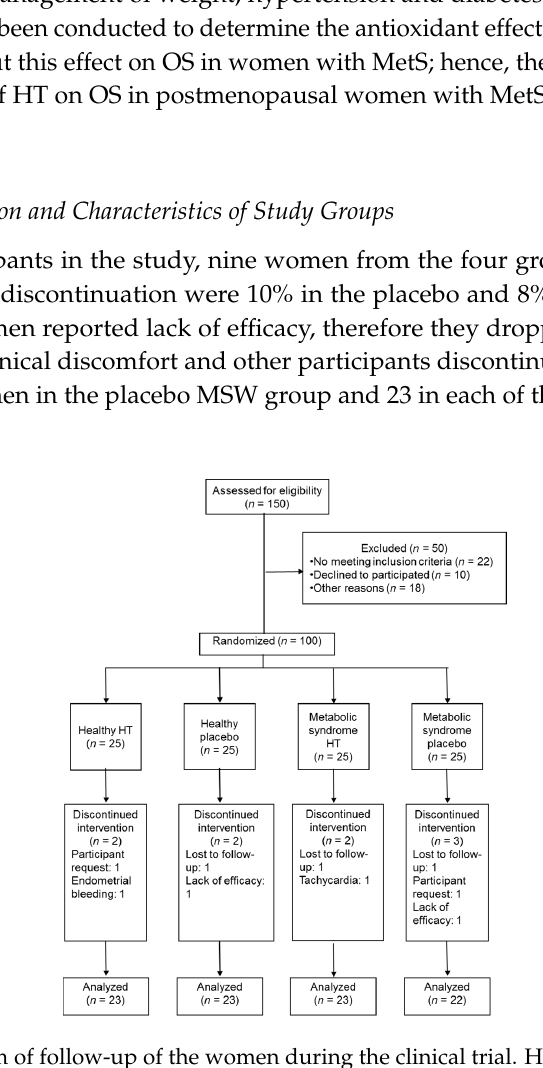
Figure 1. Diagram of follow-up of the women during the clinical trial. HT: hormone therapy.